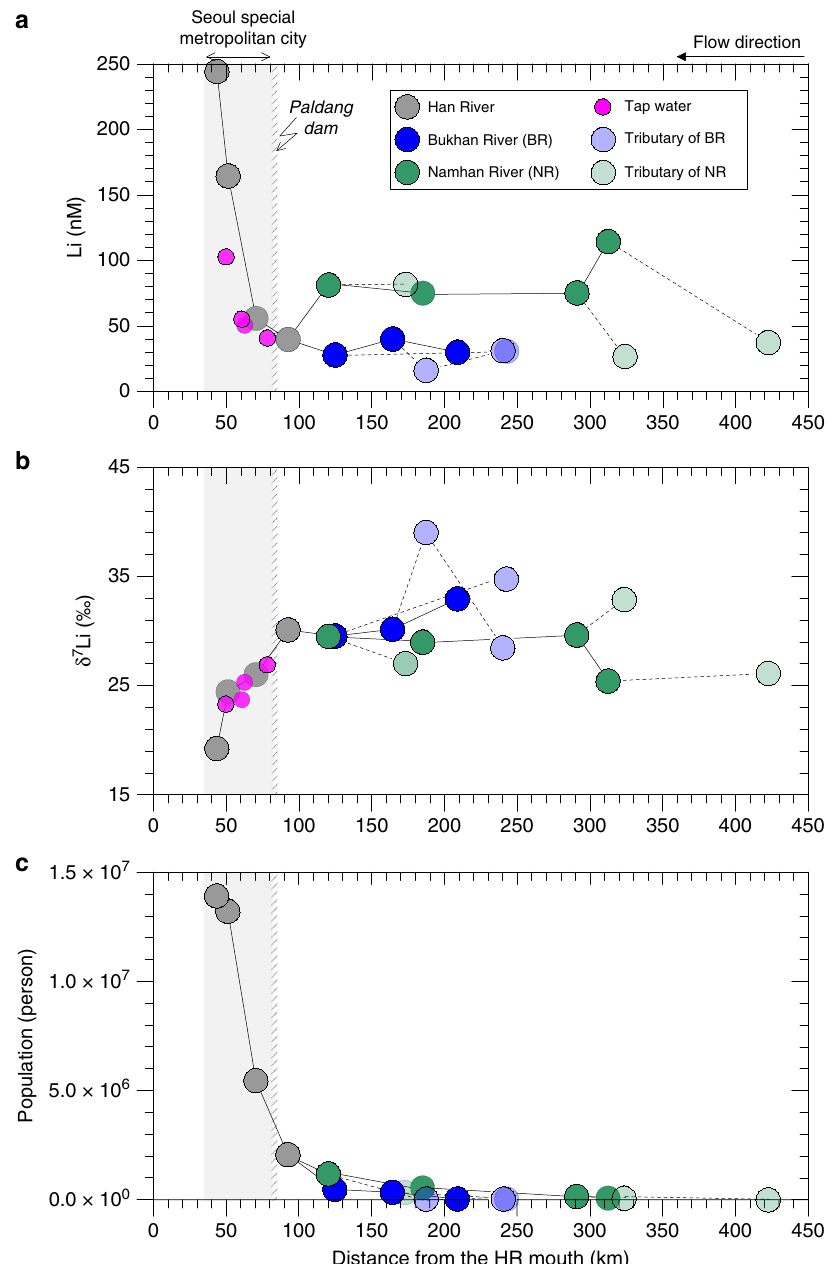
Fig. 2 Relationship between dissolved lithium and population. Spatial variation in Li concentration a and Li isotope composition b measured in river water and tap water as a function of the distance from the Han River mouth. Variation of population living in the HR basin c as a function of the distance from the Han River mouth. Half-transparent circles represent the tributary of each